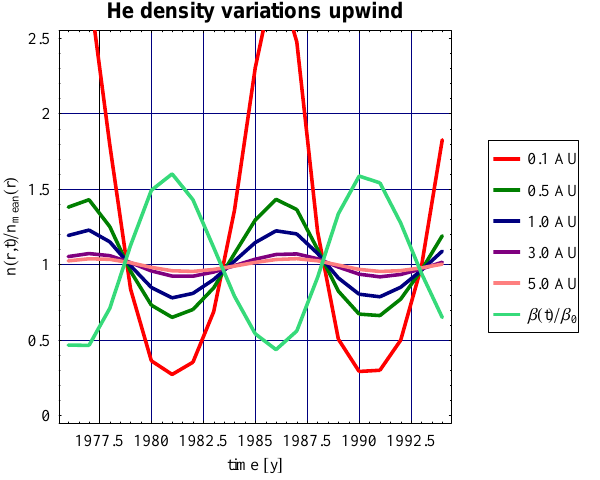
Fig. 6. Deviations of helium density from the mean at the downwind axis (i.e. in the cone), see caption to Fig.